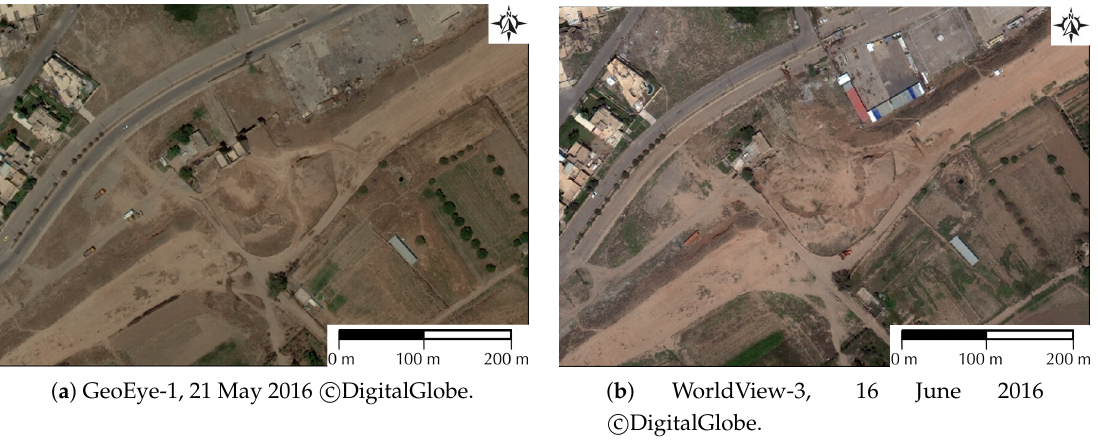
Figure 24. Satellite imagery of Nergal Gate